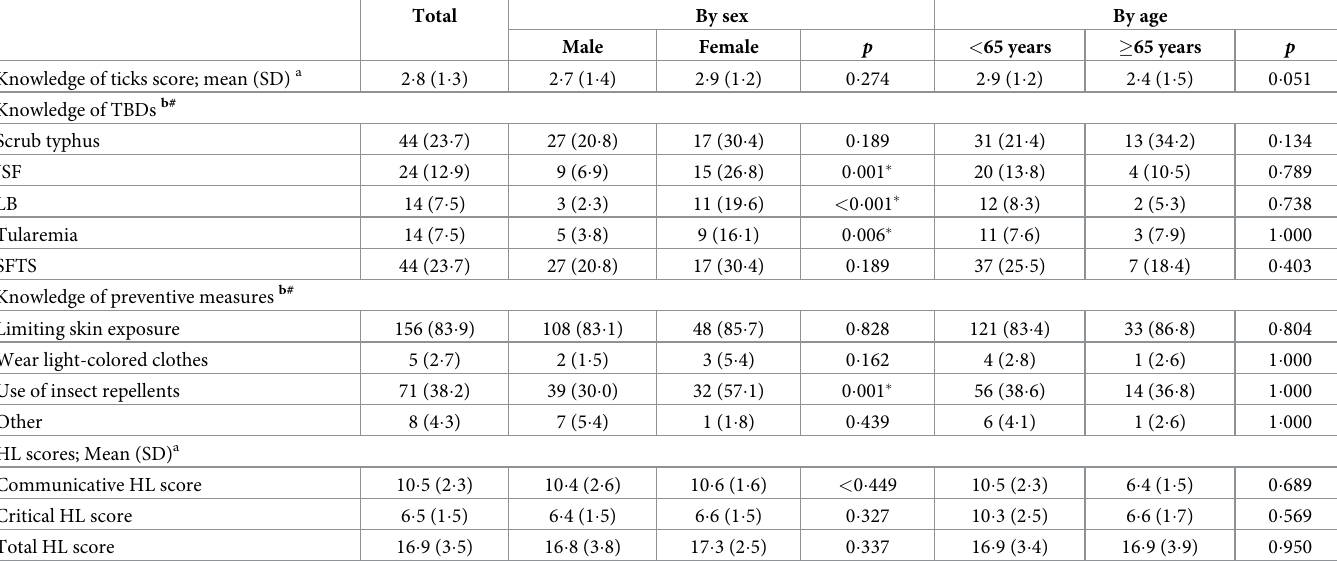
Table 2. Knowledge of TBDs and health literacy by sex and age. Total By sex By